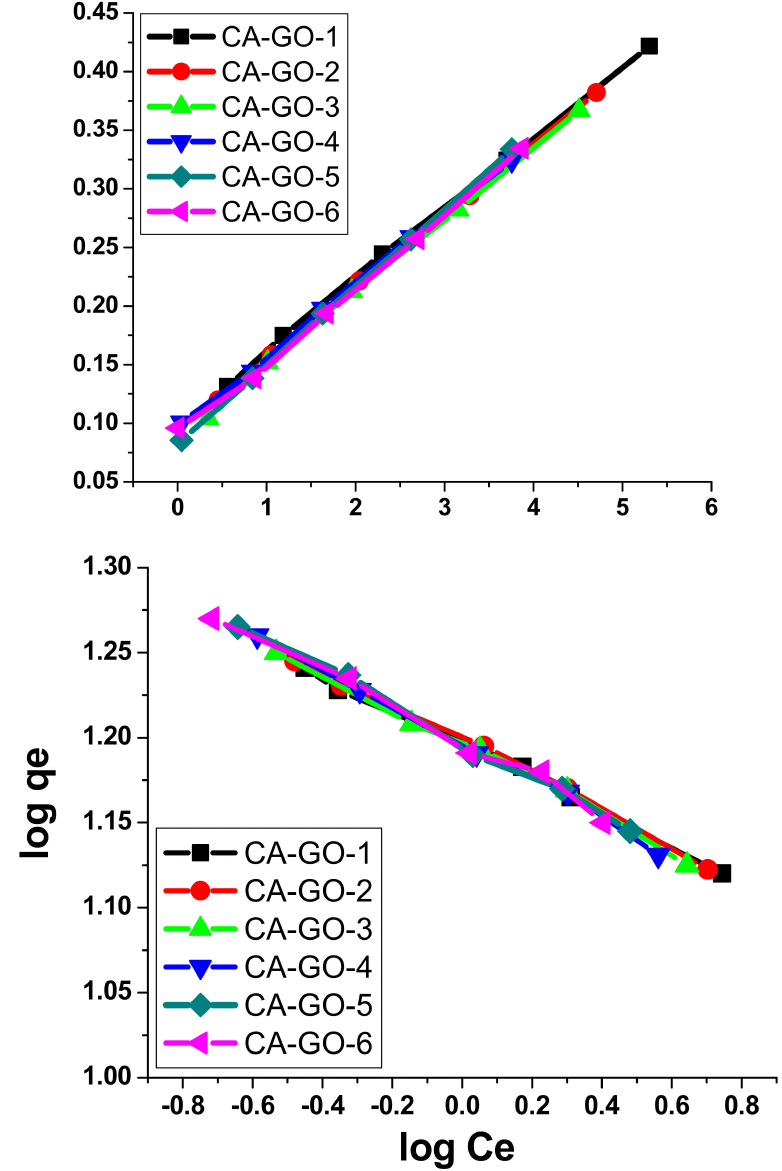
Figure 7. The Langmuir (top) and Freundlich (bottom) adsorption models using di ff erent CA-GO adsorbents under ambient conditions (25 ◦ C) for 30 min, CA-GO weight at 20 mg, and initial concentration at 15 mg /